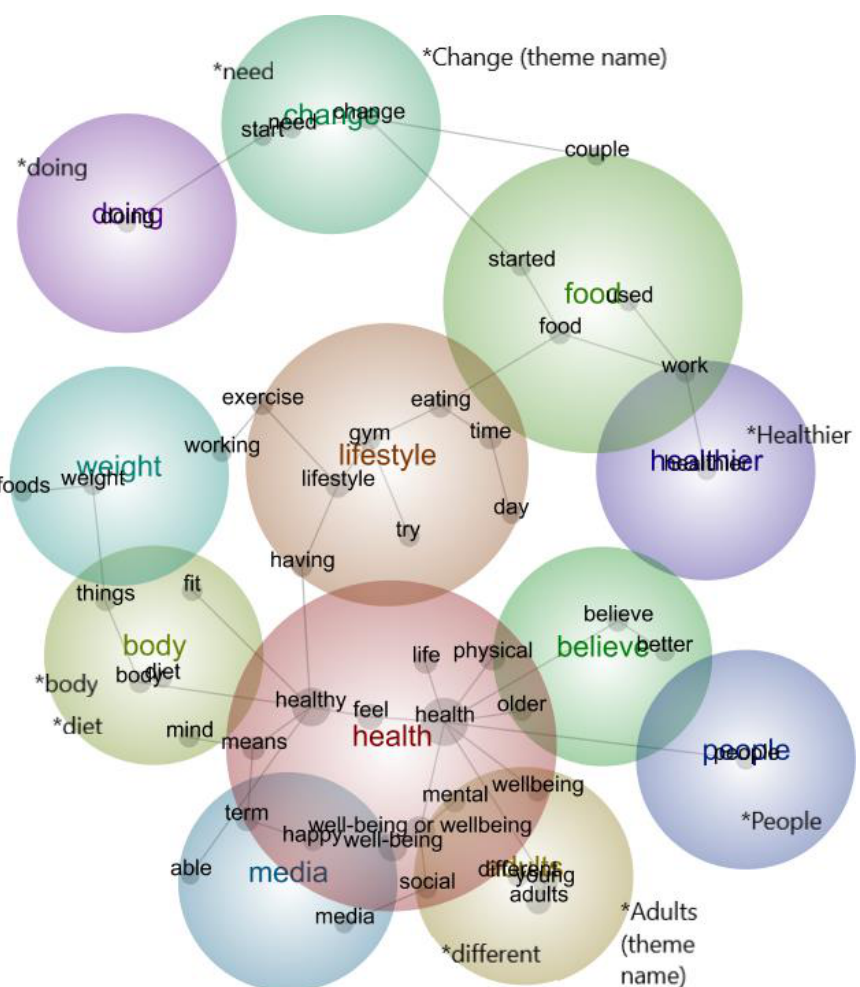
Figure A1. Leximancer TM generated concept map for Forum 4: Healthy lifestyle. *Words added manually to clarify words that were illegible in Leximancer TM output.